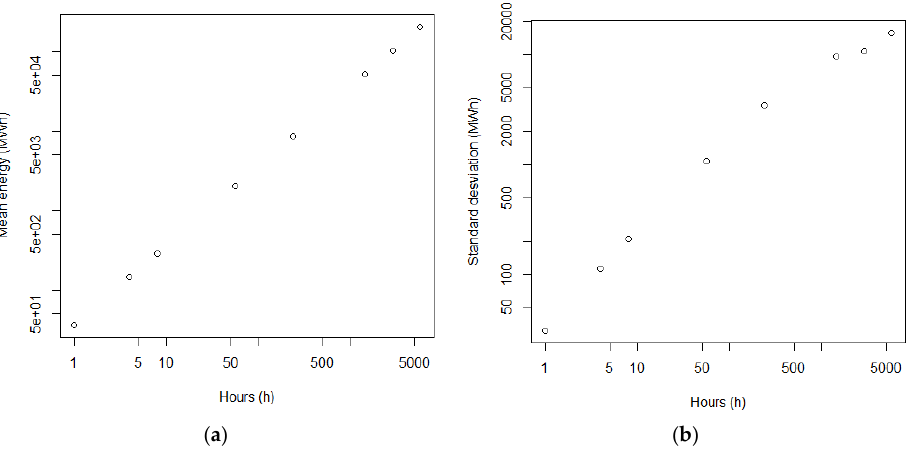
Figure 13. ( a ) Mean input generated energy of wind and wave as a function of the time interval duration. ( b ) Standard deviation generated energy function of the time interval duration.